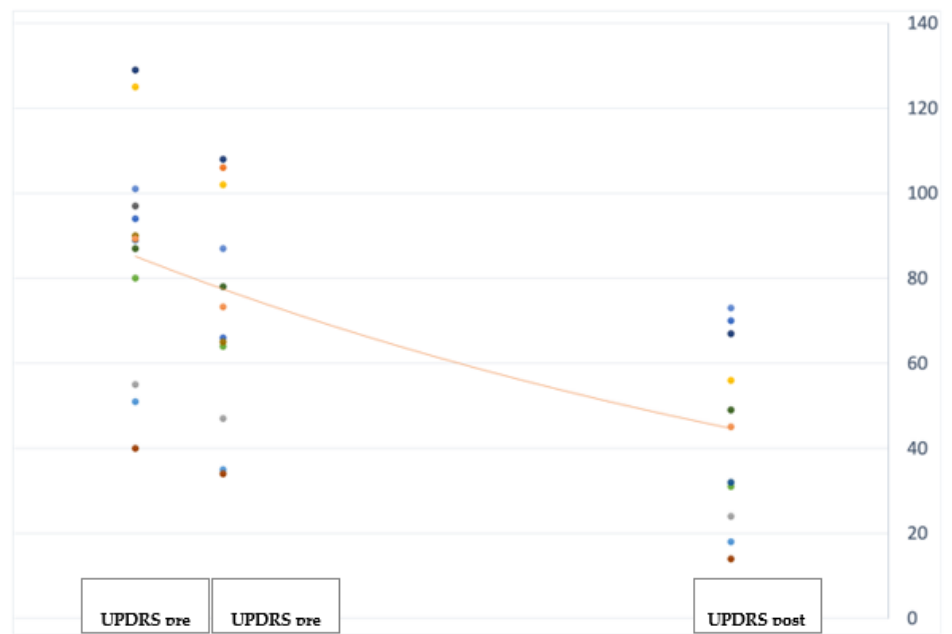
Figure 1. Jittered scattered plot showing the preoperative OFFmed and ONmed ( left ) and postop- erative ONstim ( right ) UPDRS values of the 14 patients in the study. The difference between the preoperative OFFmed and ONmed values was not significant ( p = 0.11), while the difference between the preoperative ONmed and postoperative ONstim showed a p -value = 0.00221. The line shows the negative trend of the values.